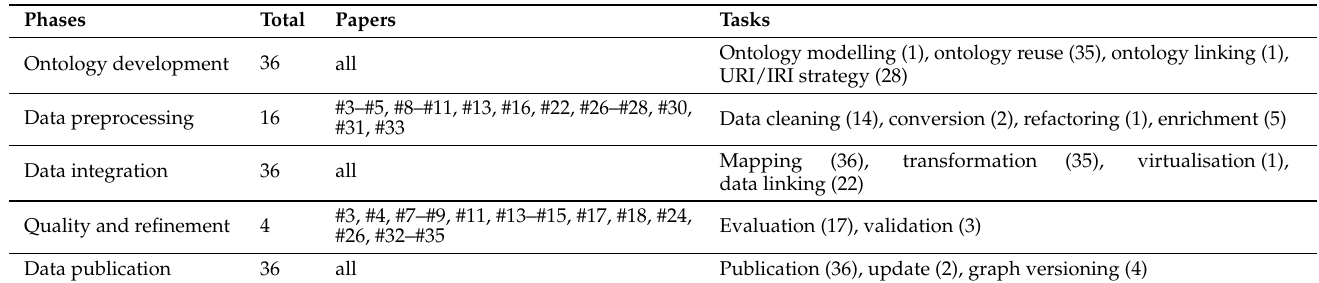
Table 3. Phases and tasks for knowledge used for graph construction.